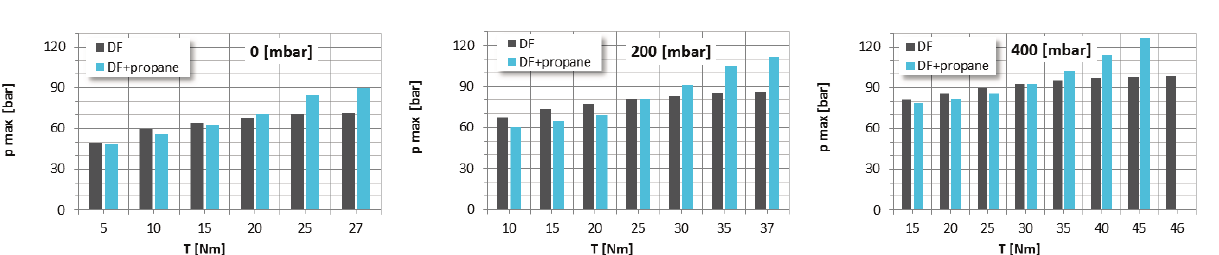
Fig. 8. Load characteristics of maximum combustion pressure courses pmax for both investigated engine operating modes